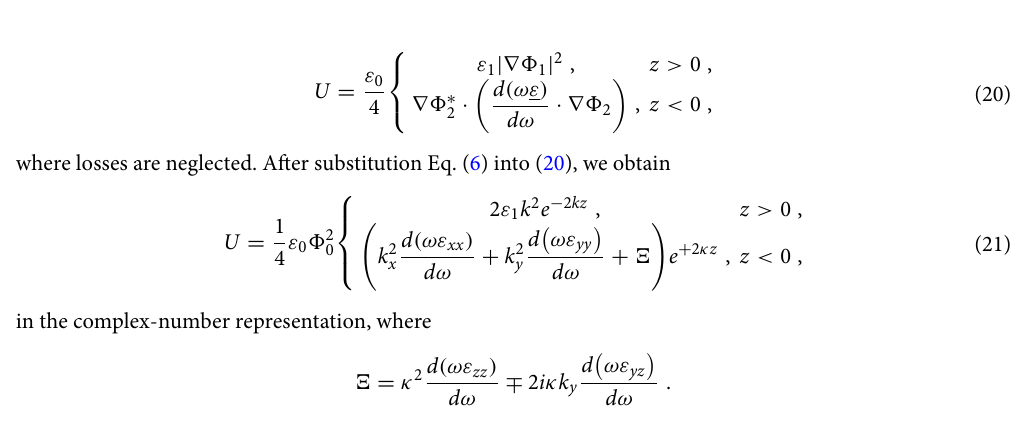
0.5 , k y > 0 , and k x has a positive constant value, corresponding to the = B 0 e x . ( b ) B 0 B 0 e x = − = +